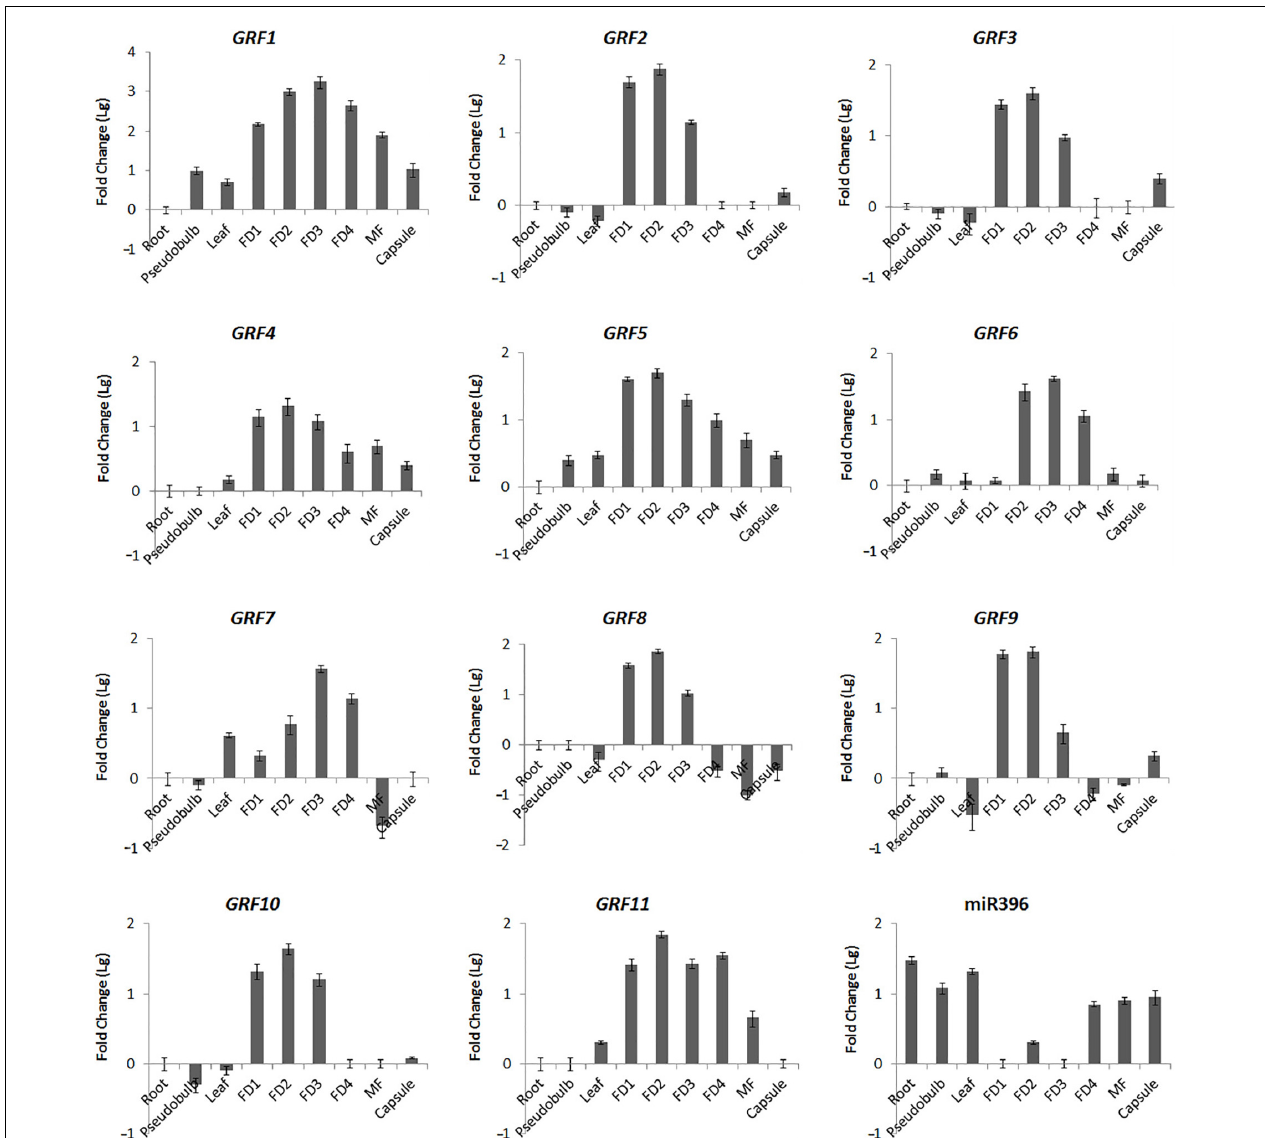
FIGURE 6 | Organ-Specific Expression of CeGRFs and Ce -miR396. Expression of CeGRF genes and Ce- miR396 in different organs examined by Real-time RT-qPCR and stem-loop PCR. Tissues analyzed: roots, pseudobulb, leaves, five stages of Floral Development (FD 1, 2, 3, 4, and mature flower (MF). The Y-axis indicates fold change (Log value) in expression among different plant organs and the floral buds at different developmental stages. Expression levels were normalized using the threshold cycle values obtained for the Ubiquitin gene. Root and FD1 were used as a standard in presenting fold change (Lg) of CeGRFs and Ce -miR396, respectively. Error bars indicate the standard deviation of the mean (SD) ( n = 3). Three replicates were analyzed, with similar